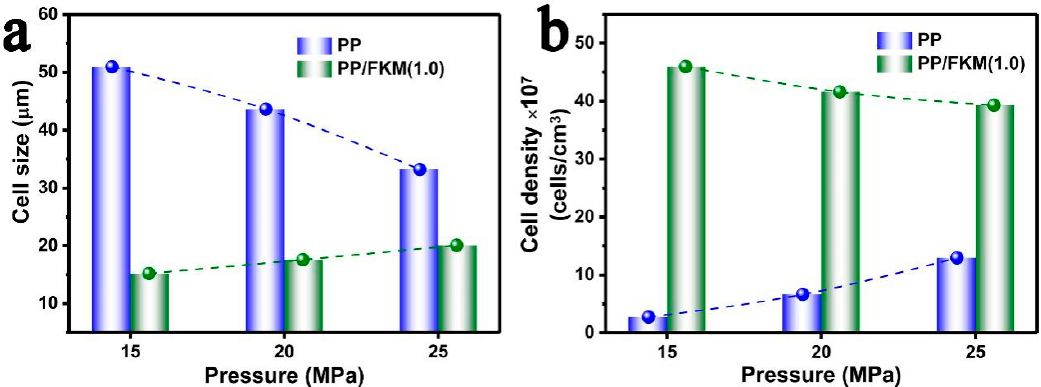
Figure 7. ( a ) Cell size and ( b ) cell density of PP/FKM(1.0) foams prepared at 152 °C and different saturation pressures.